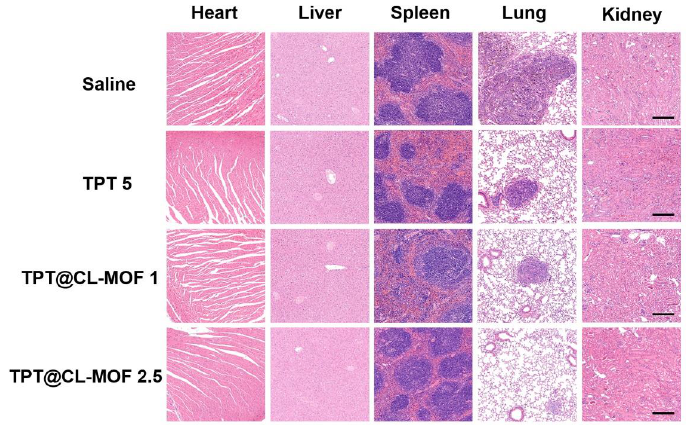
Figure 6. Histological observation of heart, liver, spleen, lung, and kidney. Scale bars, 200 µm.